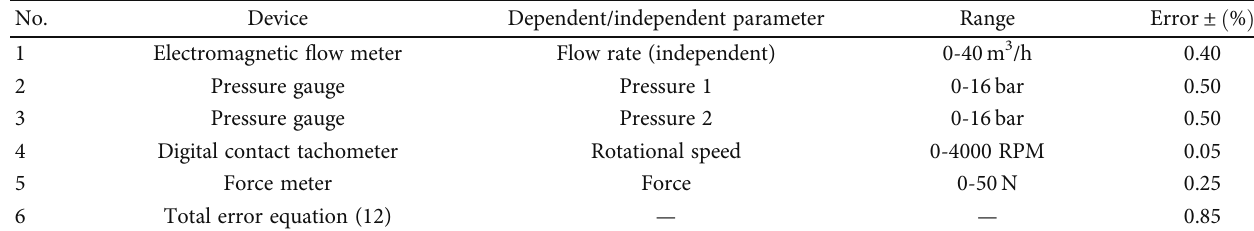
Figure 4: Experiment setup. Table 3: Lists of measuring devices.